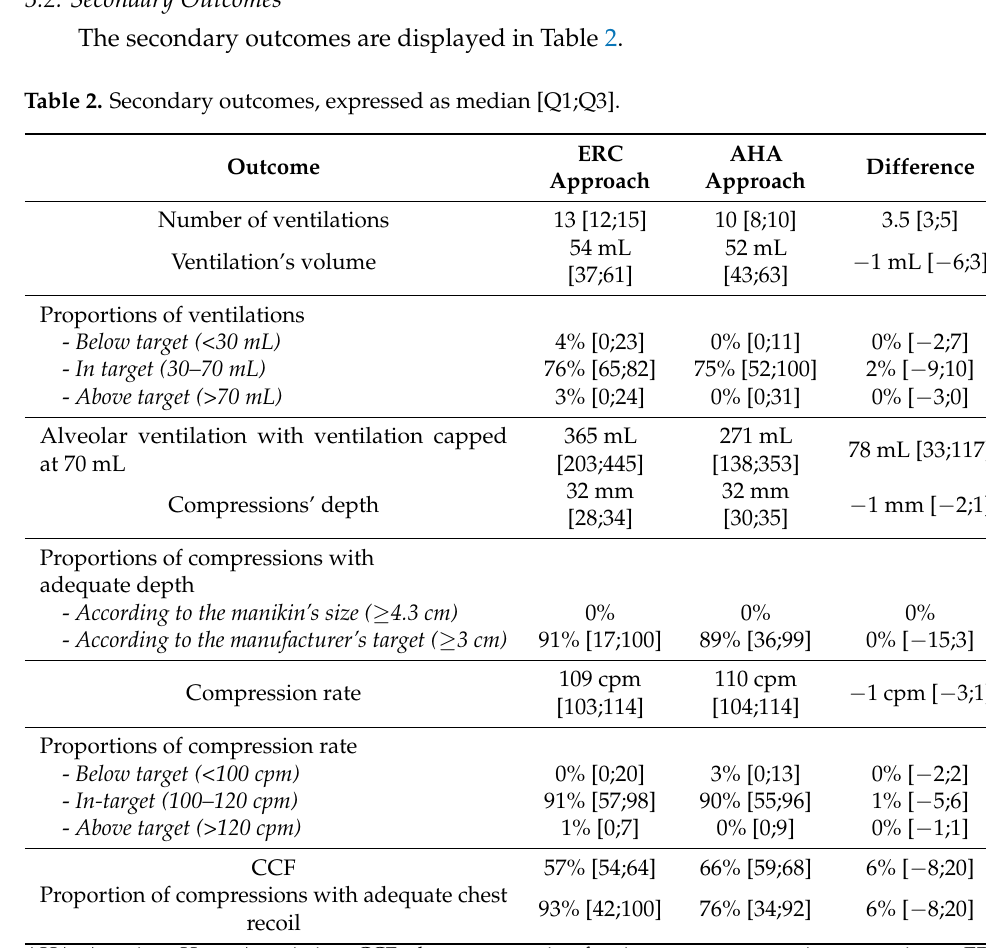
Figure 2. Alveolar ventilation during the first minute of resuscitation.